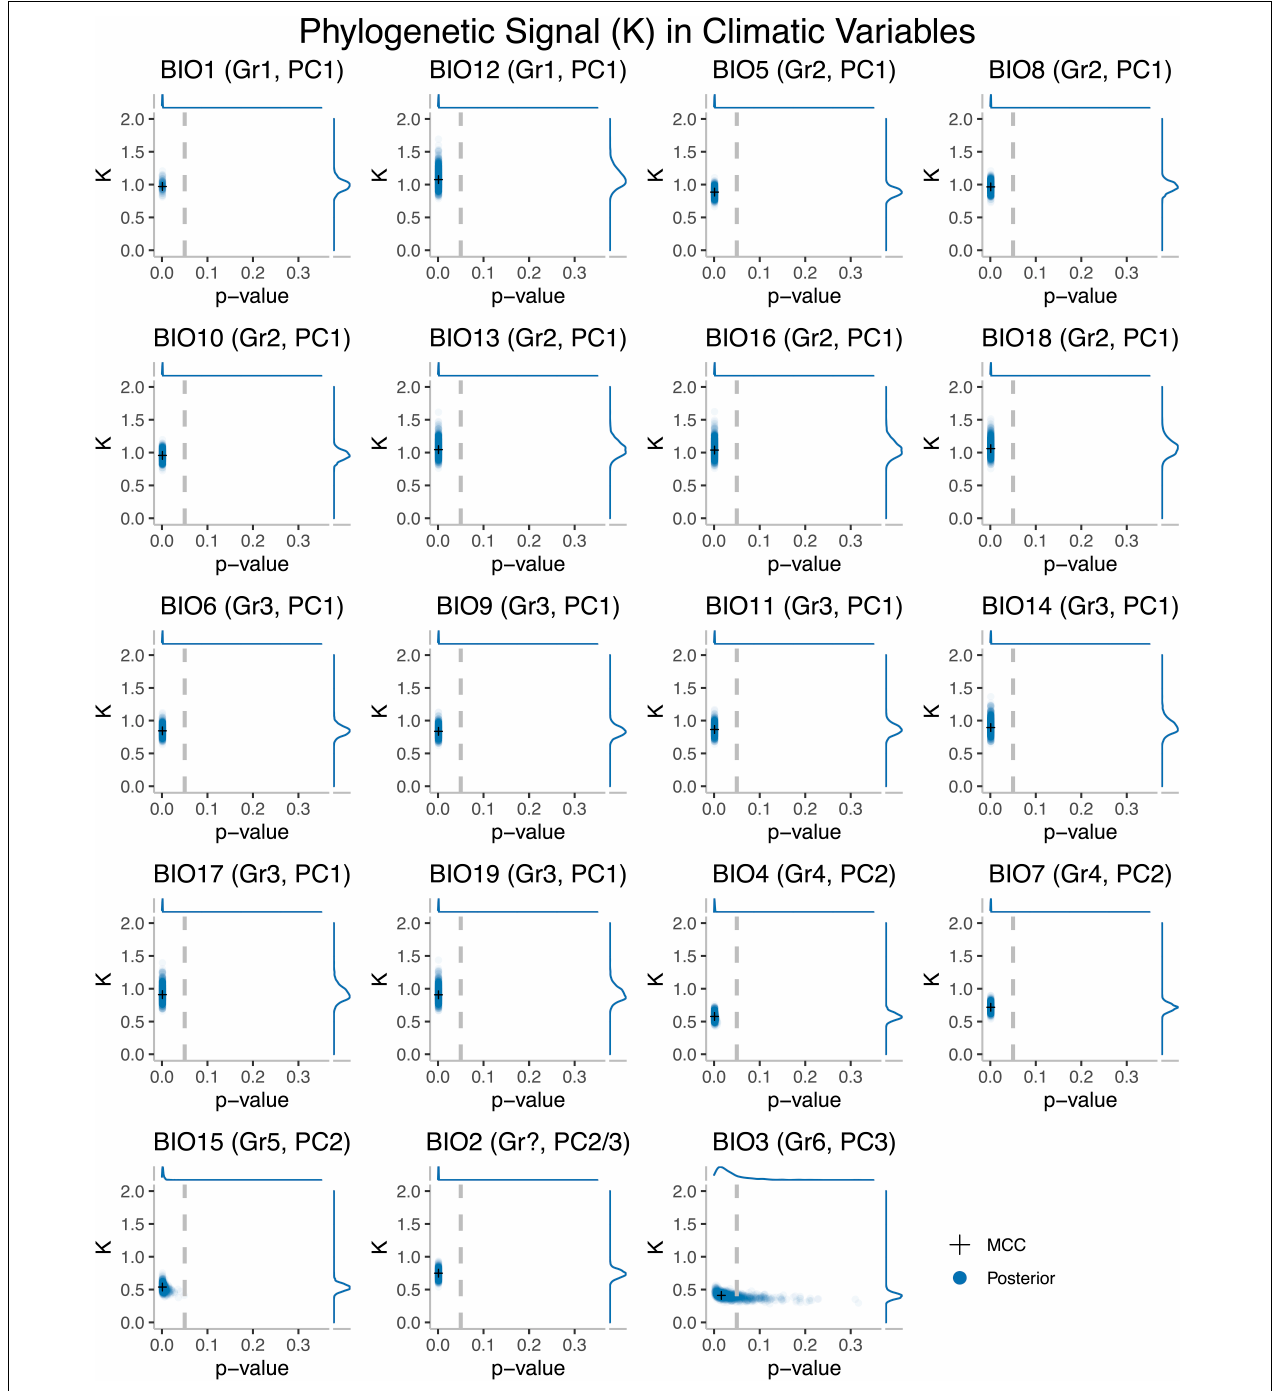
FIGURE 1 | Phylogenetic signal (K) and p -values for 19 bioclimatic variables as calculated on the MCC tree (crosses) and 1,000 trees derived from the posterior (circles) for Trebouxia . Climatic variable Group 1 includes: Annual Mean Temperature (BIO1), Annual Mean Specific Humidity (BIO12). Climatic variable Group 2 includes: Max Temperature of Warmest Month (BIO5), Mean Temperature of Most Humid Quarter (BIO8), Mean Temperature of Warmest Quarter (BIO10), Specific Humidity of Most Humid Month (BIO13), Specific Humidity Mean of Most Humid Quarter (BIO16), Specific Humidity Mean of Warmest Quarter (BIO18). Climatic variable Group 3 includes: Min Temperature of Coldest Month (BIO6), Mean Temperature of Least Humid Quarter (BIO9), Mean Temperature of Coldest Quarter (BIO11), Specific Humidity of Least Humid Month (BIO14), Specific Humidity Mean of Least Humid Quarter (BIO17), Specific Humidity Mean of Coldest Quarter (BIO19). Climatic variable Group 4 includes: Temperature Seasonality (Standard Deviation * 100) (BIO4), Temperature Annual Range (BIO5–BIO6) (BIO7). Climatic variable Group 5 is limited to Specific Humidity Seasonality (Coefficient of Variation) (BIO15), while Group 6 is restricted to Isothermality (BIO2/BIO7) (*100) (BIO3). It is unclear which group Mean Diurnal Range Temperature (BIO2) belongs